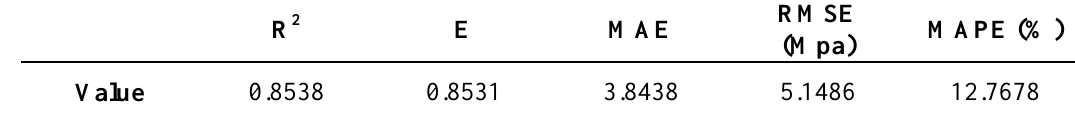
R 2 , E, MAE, RMSE, and MAPE Values of ANFIS